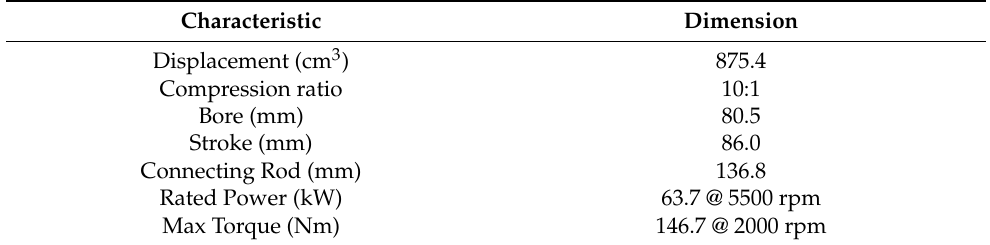
Table 1. PFI twin-cylinder engine’s main